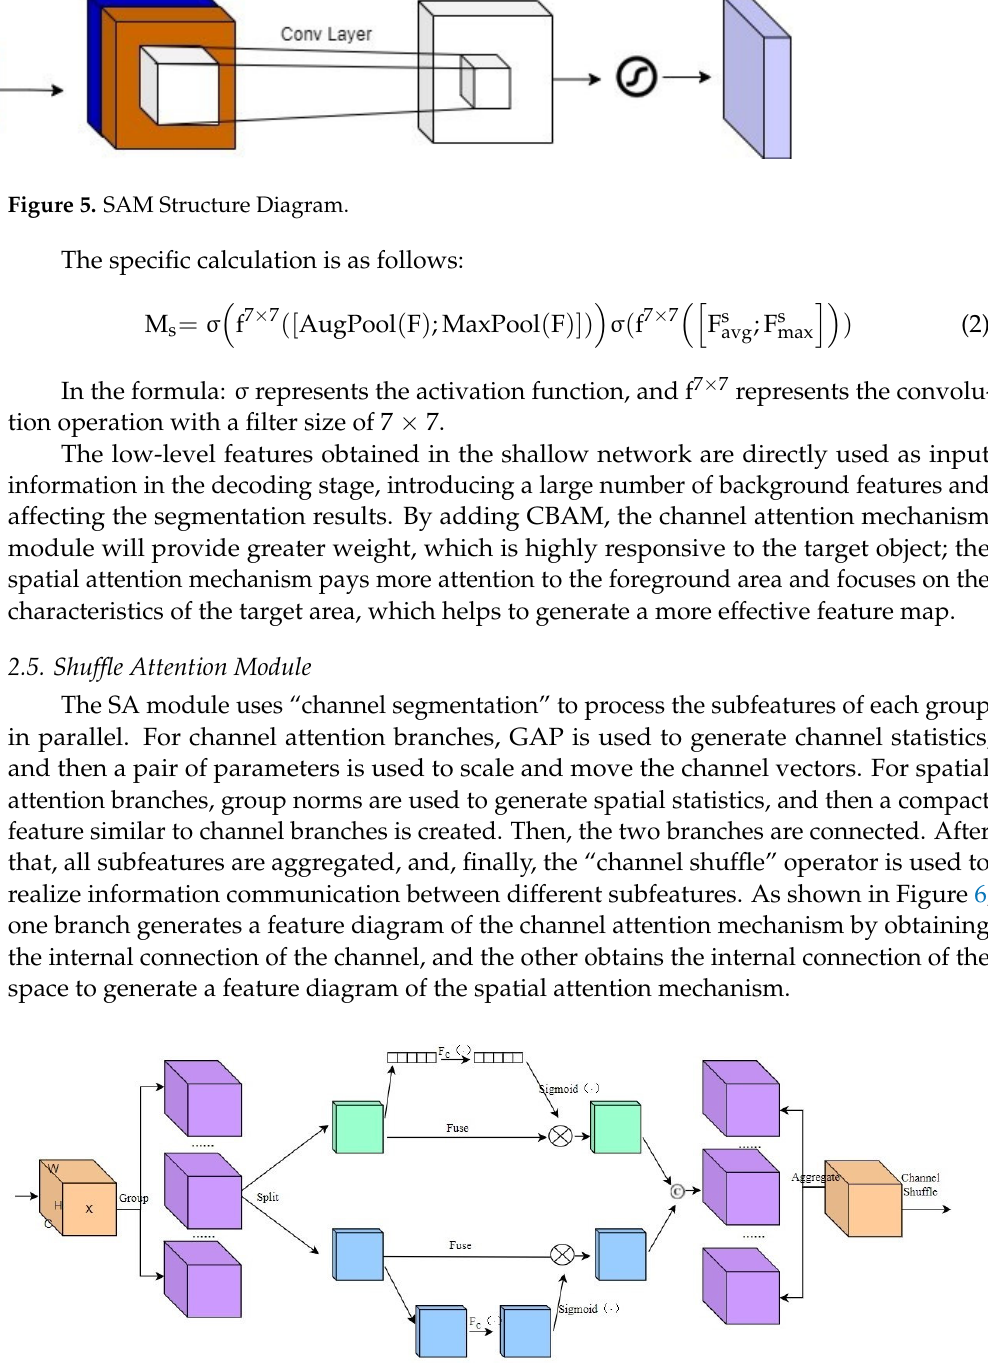
Figure 6. SA Overall Architecture Diagram. Channel Attention: For a given feature map X ∈ R C × H × W , where C, H, and W represent the channel, spatial height, and spatial width, respectively, the SA module first divides X into group G along the channel size, that is, X = [X 1 , . . . , X G ]; moreover, X k ∈ R C/G × H × W , where each subfunction X k gradually capture specific semantic responses during